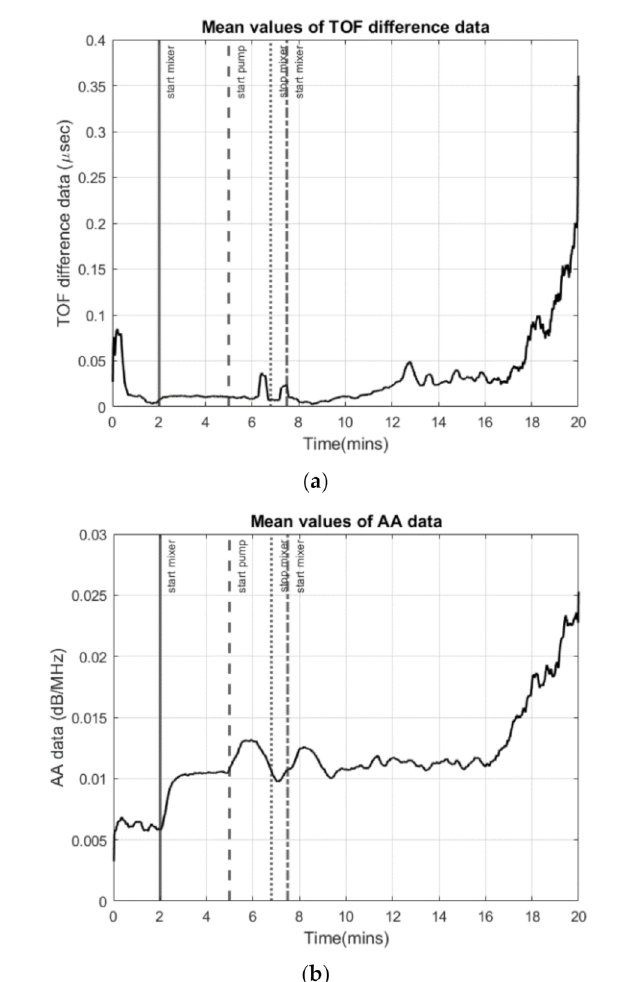
Figure 14. ( a ) Mean value of TOF data. ( b ) Mean value of acoustic attenuation data (in dB/MHz). In both cases: mixer on at 2 min and pump on at 5 min, stop of stirrer at 7.5 min, and stirrer starts again at 8